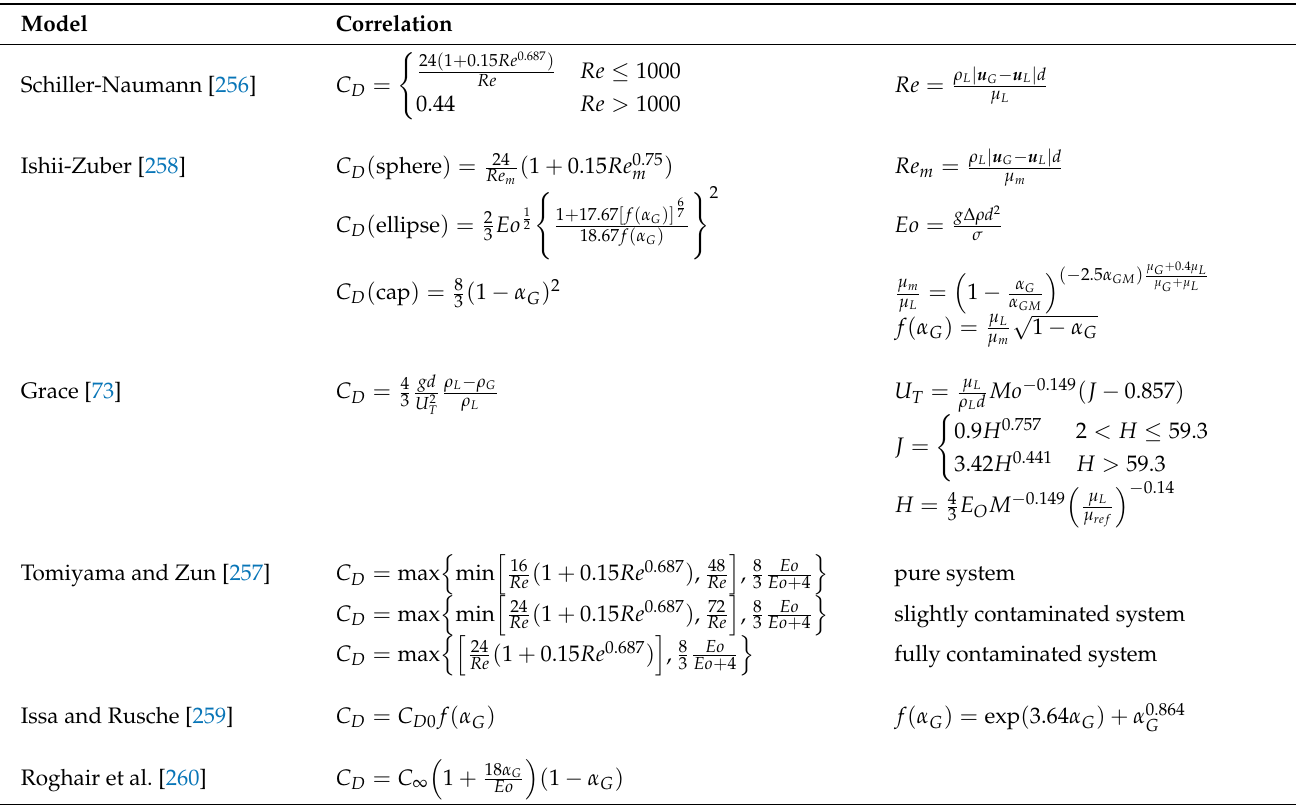
Table 7. Drag coefficient correlations.